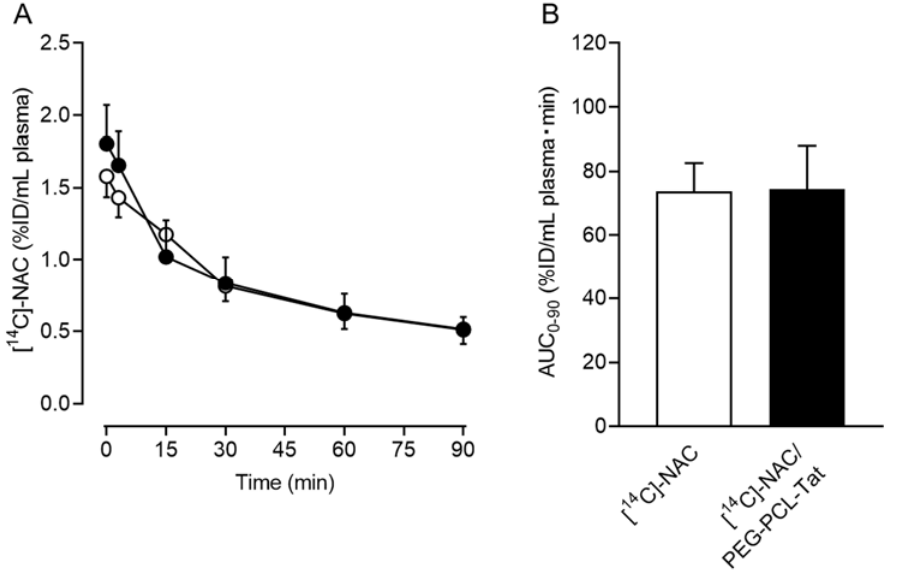
Figure 2. Concentration-time profiles of [ 14 C]-NAC in plasma after a single intranasal administration to ddY mice and the area under the plasma concentration time curve (AUC). ( A ) Plasma was obtained from the blood collected at the designated time after the intranasal administration of [ 14 C]-NAC ( ◦ ) or [ 14 C]-NAC/PEG-PCL-Tat (•). The %ID in mL plasma represents the ratio of the distribution in plasma to the dosing volume of an intranasally administered drug. Values represent the mean ± SE ( n = 6 or 7); ( B ) AUC 0–90 was calculated using a linear trapezoidal method and values for plasma concentration to the last time point ( t = 90 min) were obtained. Values represent the mean ± SE ( n = 6 or 7). The significant differences in mean plasma concentrations at the same time or AUC 0–90 between the two groups were analyzed using a t